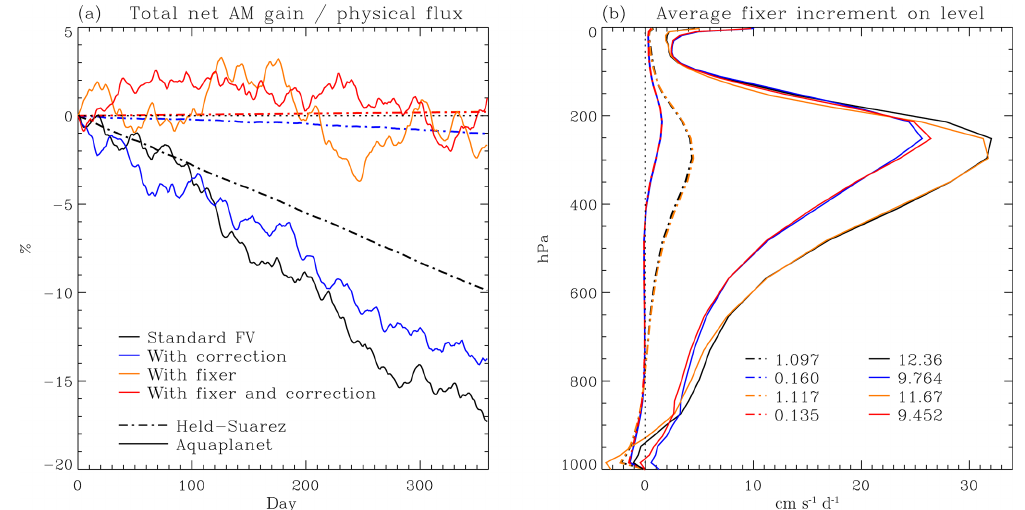
Figure 6. AM correction and fixer in Held–Suarez (HS) and aquaplanet (AP) integrations. Panel (a) shows the time evolution of total AM for each of the integrations, similar to Fig. 3 (diamond shapes) but normalised separately for each integration to the time-integrated physical (i.e. surface stress) torque at day 360. AP integrations are shown in solid, HS integrations in stippled lines. The colour coding is as in Fig. 3. Panel (b) shows the time-mean numerical torque, averaged over days 120–360, arising at each model level from advective increments, as diagnosed by the fixer and expressed as equatorial acceleration in a solid-body rotation required to compensate for the numerical sink. Line types and colours correspond to those shown in (a) . The lists at the bottom of (b) indicate the time-mean equatorial accelerations of a global solid-body rotation, i.e. the increments shown by the lines but integrated vertically level by level, weighted with the appropriate moments of